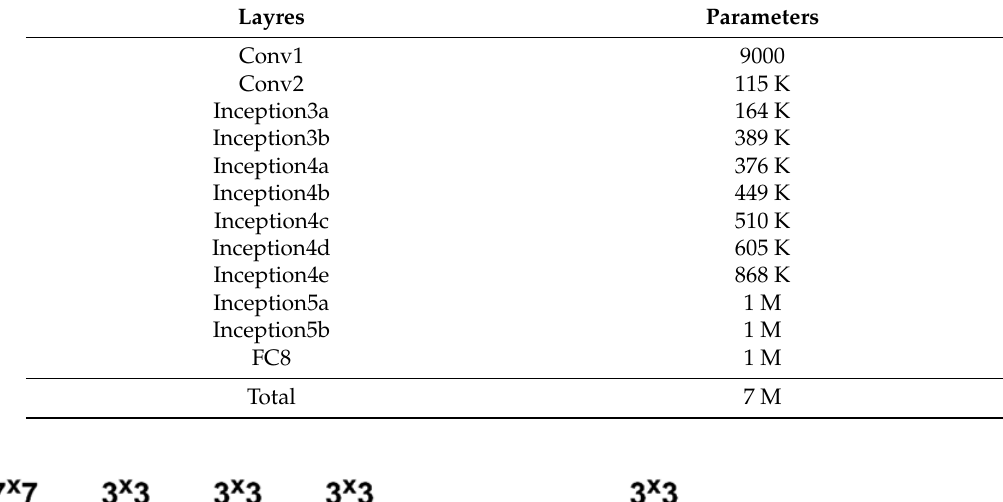
Table 1. the number of parameters per layer in the GoogLeNet model. Table 1. The number of parameters per layer in the GoogLeNet model.